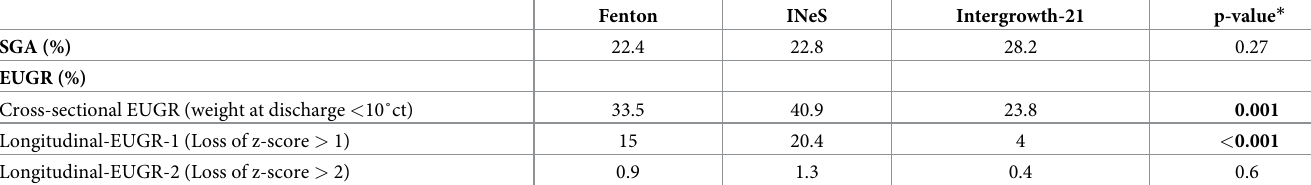
Table 1. Distribution of SGA and EUGR according to different reference growth charts in our VLBW